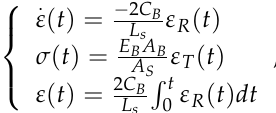
Figure 4. Strain circuit pulse signal-time curves of Zr/PTFE, Ti/PTFE at 298 K. ( a ) Zr/PTFE, ( b ) Ti/PTFE.